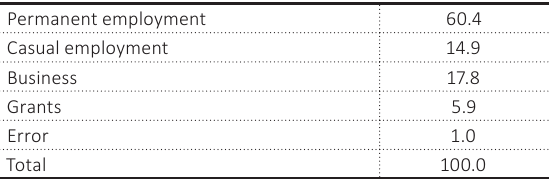
Table 1. Percentage’s sources of income